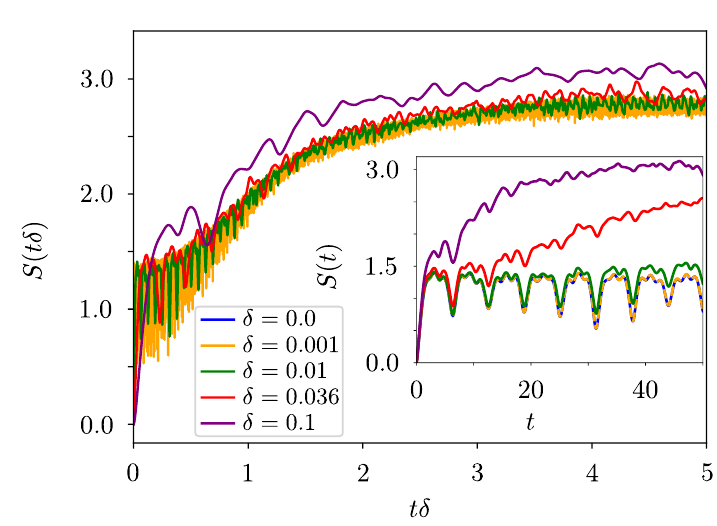
Figure 10: Rescaled entropy growth for δ = 0.001 (orange), δ = 0.01 (green), δ = 0.036 (red), δ = 0.1 (purple) and L = 6 rungs. The time is rescaled by the de- tuning factor δ